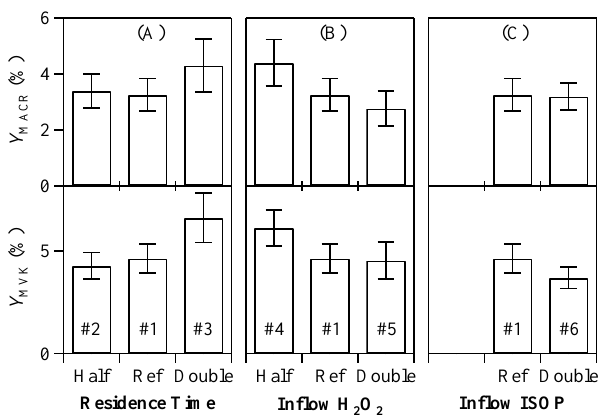
Fig. 3. Yields of MACR (top) and MVK (bottom) for HO 2 - dominant conditions. (A) Variable residence time. (B) Variable in- flow concentration of H 2 O 2 . (C) Variable inflow concentration of ISOP. The labeled experiment numbers refer to Table